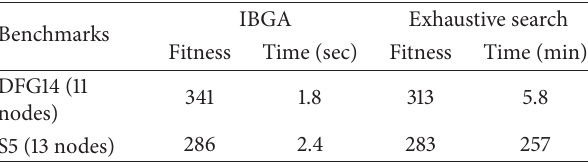
Table 14: Exhaustive versus IBGA (average of 10